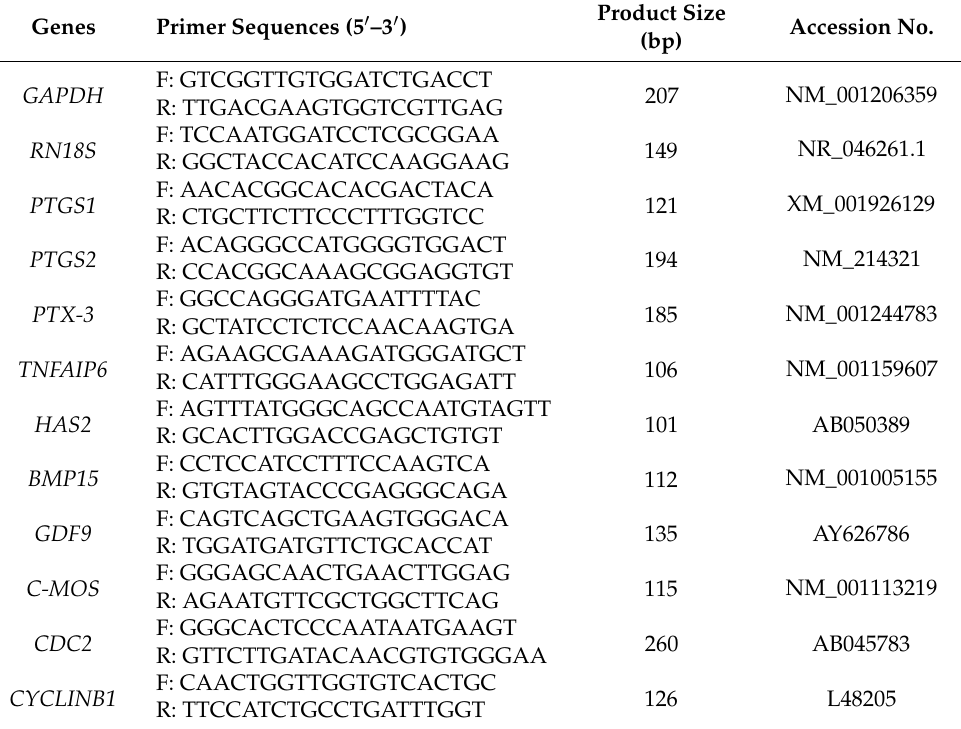
Table 1. Primer sequences used for real-time